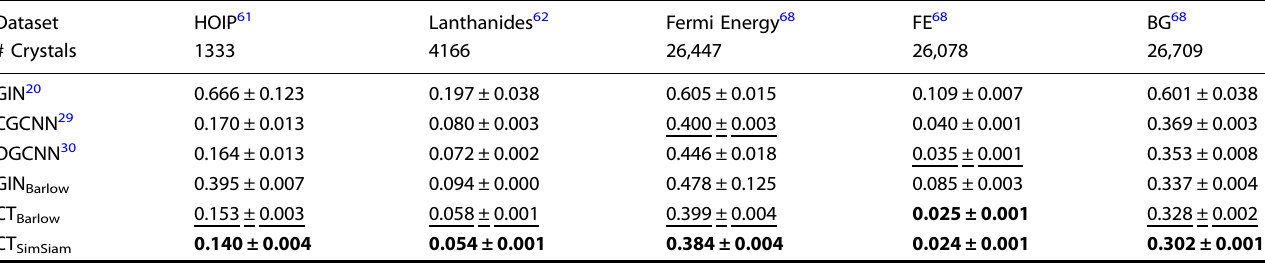
Table 3. Mean and standard deviation of test MAE of Crystal Twins (CT) in comparison to the supervised baselines on 5 regression